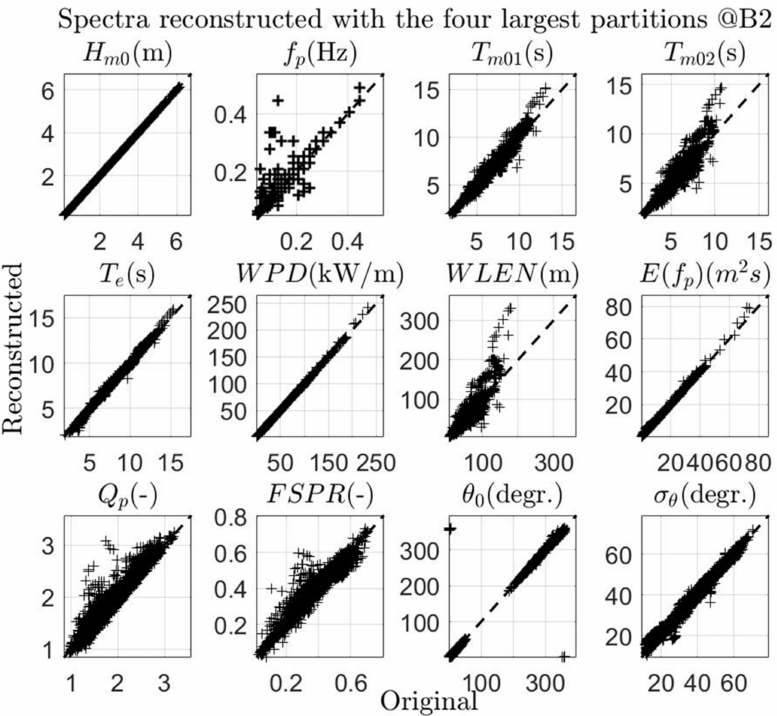
Figure 4. Scatter plots for KPs obtained from the original and the reconstructed spectra (with the four largest partitions) at check point B2. Table 4. Mean absolute error (MAE) of the KPs derived from the original and the reconstructed spectra/partitions at check point B2. Sample numbers of Part0 to Part6 are 8760, 6407, 8729, 3295, 1483, 449, and 97,